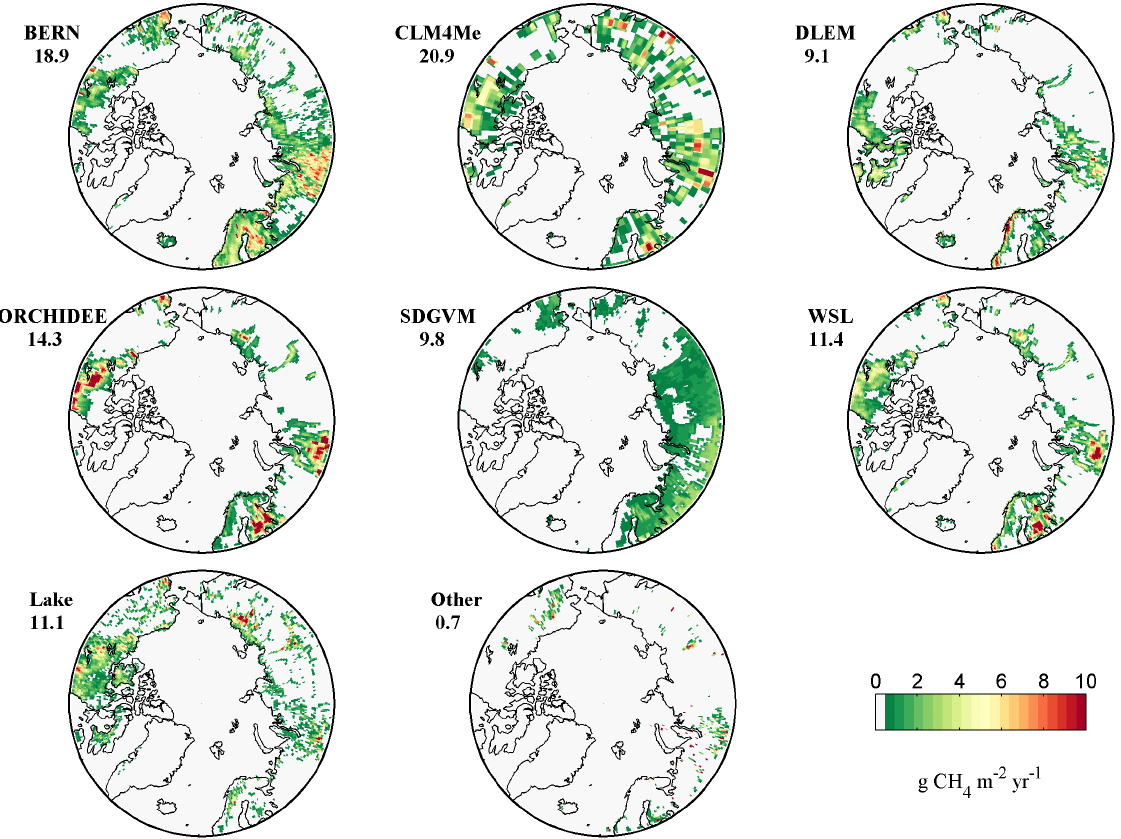
Figure 2. Prior average CH 4 fluxes from wetlands, lakes, and other sources (i.e., anthropogenic and biomass burning) in 2005 used for the pan-Arctic nested-grid inversions at 1/2 ◦ × 2/3 ◦ resolution. Annual total emission for each pan-Arctic source is presented in units of Tg CH 4 yr − 1